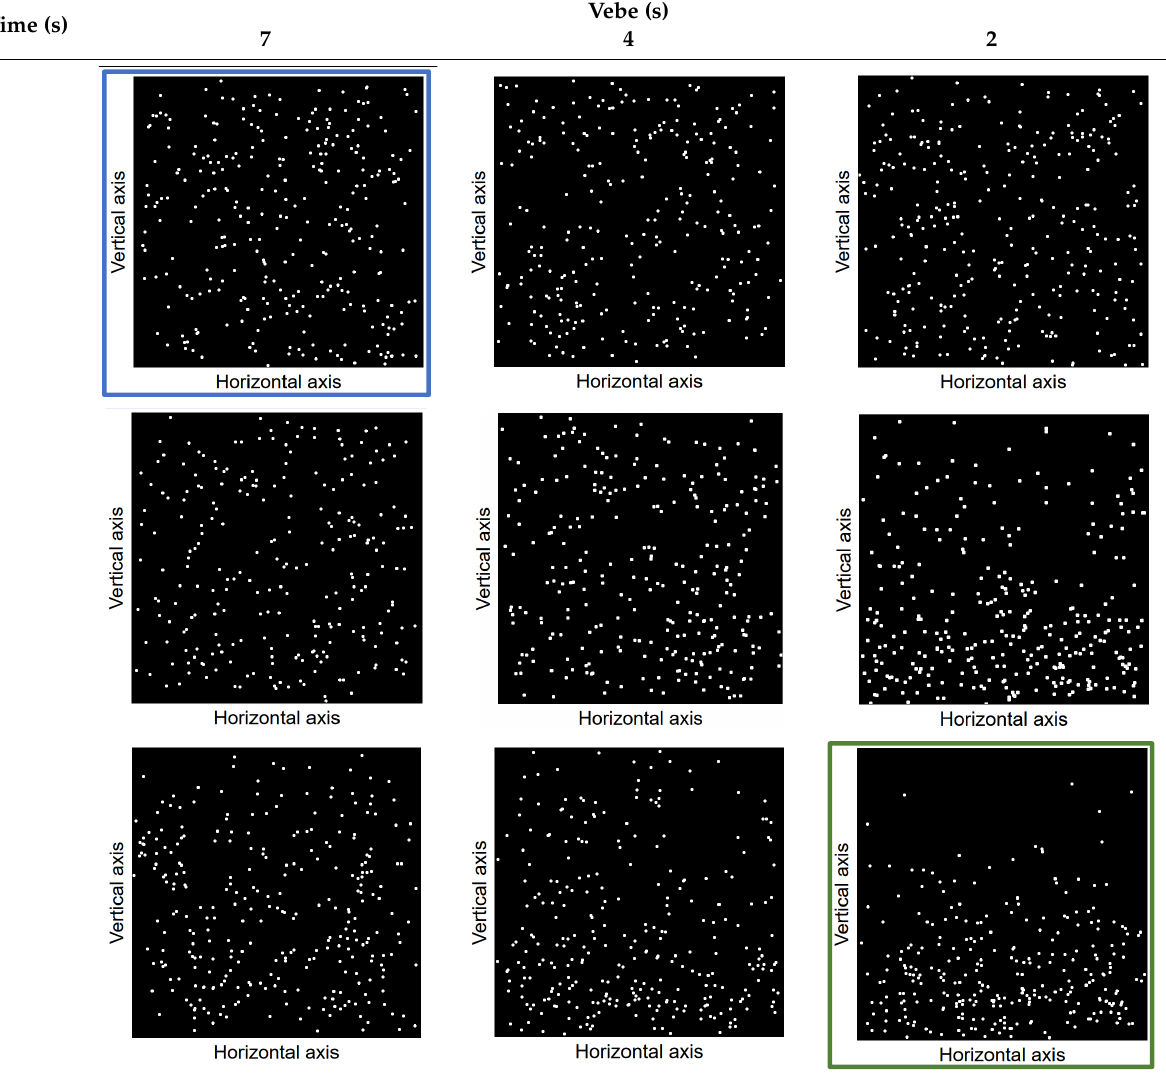
Table 6. The calculated fibre distribution in a cross-section of a cubic specimen. Data was generated using GT-Kw probability distribution with parameters corresponding to various vibration time and Vebe consistency (see Tables 3 and 4).